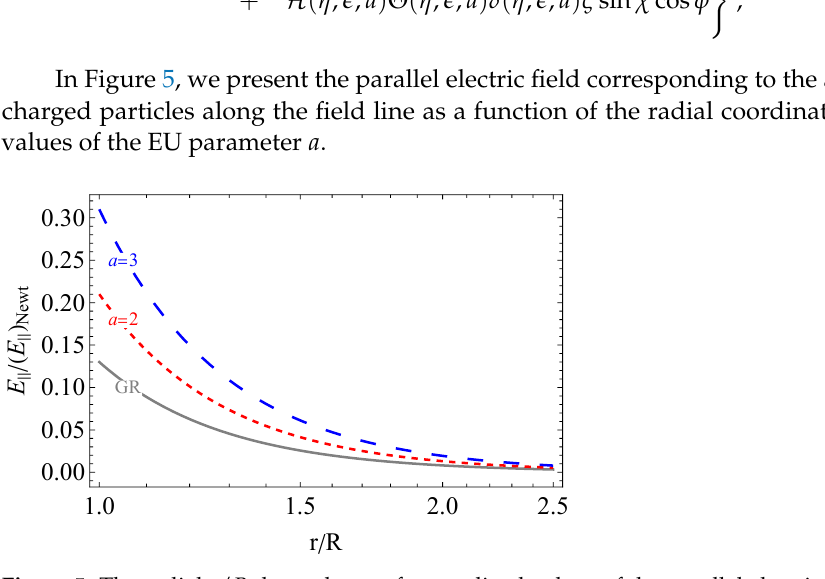
Figure 5. The radial r / R dependence of normalized values of the parallel electric fields in the EU and in GR to its Newtonian value for different values of the parameter a when compactness of the star (cid:101) =